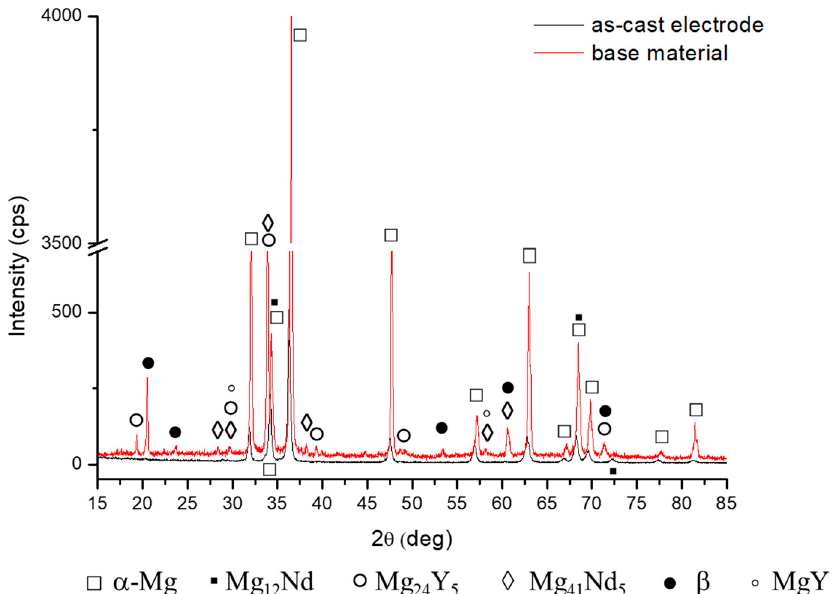
Figure 4. X-ray diffractometer (XRD) patterns of the as-cast (electrode) and peak-aged WE43 alloy (base material).